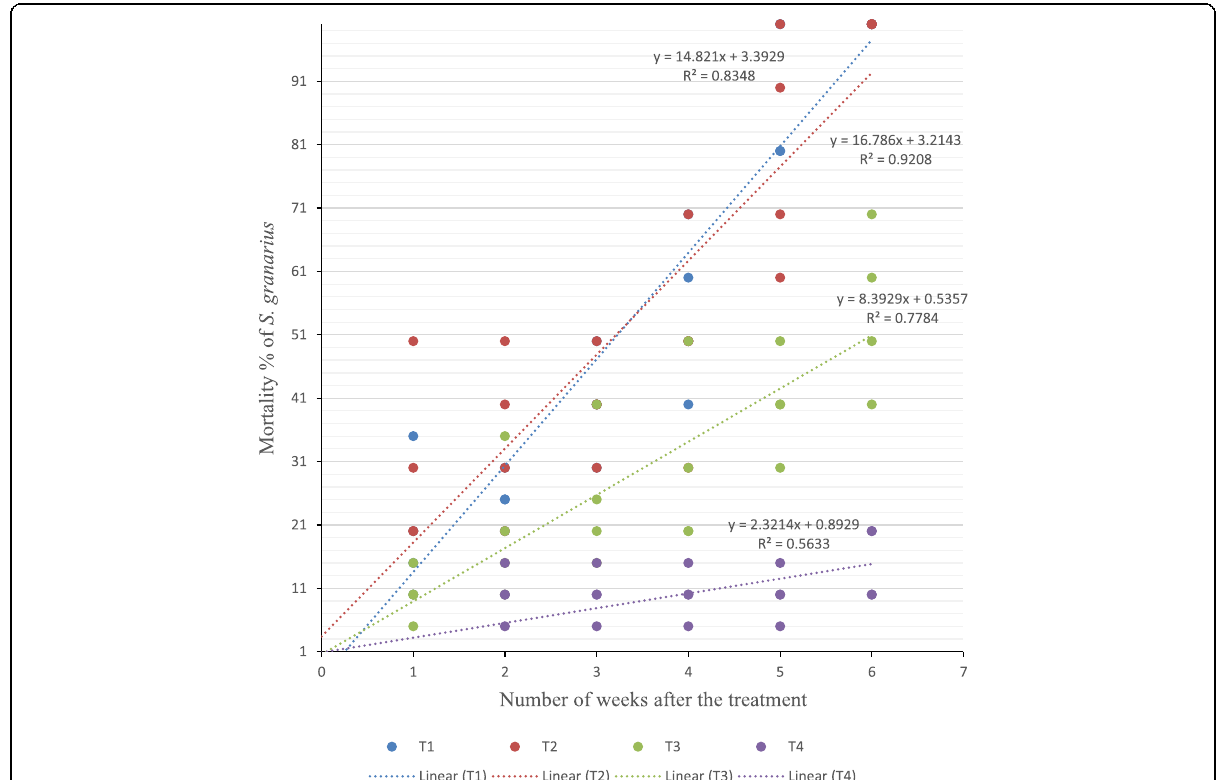
Fig. 4 Mortality of adults of the granary weevils ( Sitophilus granarius ; strain SG5) as a result feeding on mixtures of Beauveria bassiana (strain BB2) conidia + wheat flour for 24 h. Ratios of mixtures (g/g) are T1 = 0.2:2.0; T2 = 0.1:2.0; T3 = 0.05:2.0; T4 =